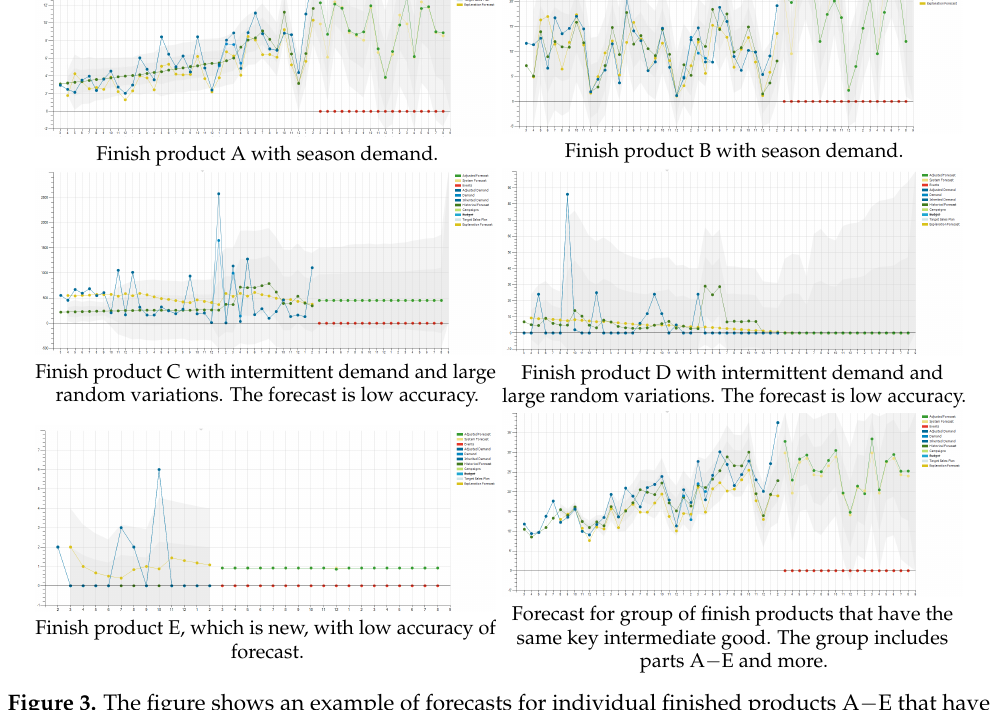
Figure 3. The figure shows an example of forecasts for individual finished products A − E that have the same key intermediate good implemented in IFS Application. The group was selected according to the proposed algorithm. The final product A and final product B are the most commonly sold products in the group. Demand aggregated for a group which includes products A − E is seasonal and forecasts better than individual final